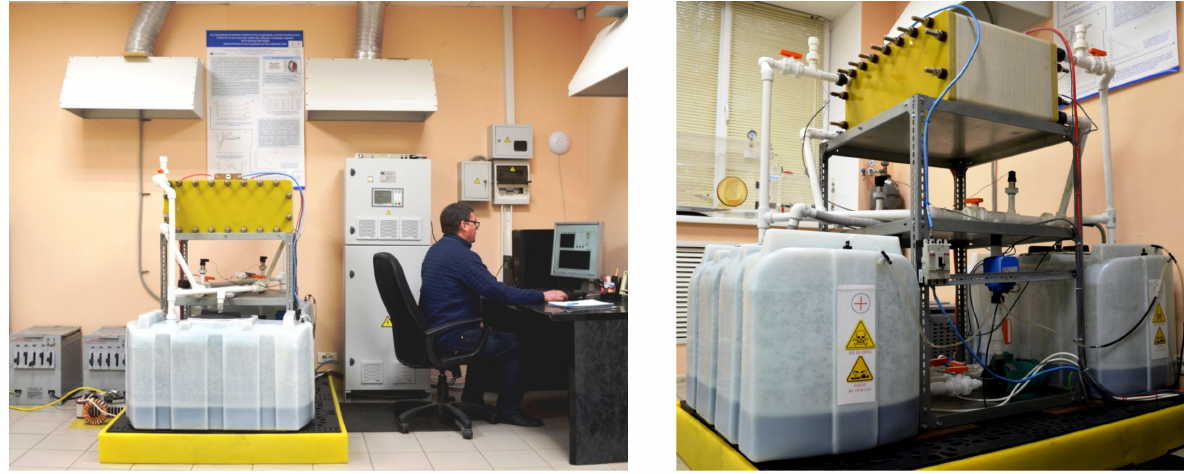
Figure 2. 6 kWh VRB test